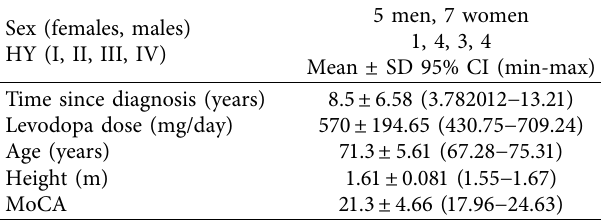
Figure 4: Flowchart of research sample losses. Table 5: Sample